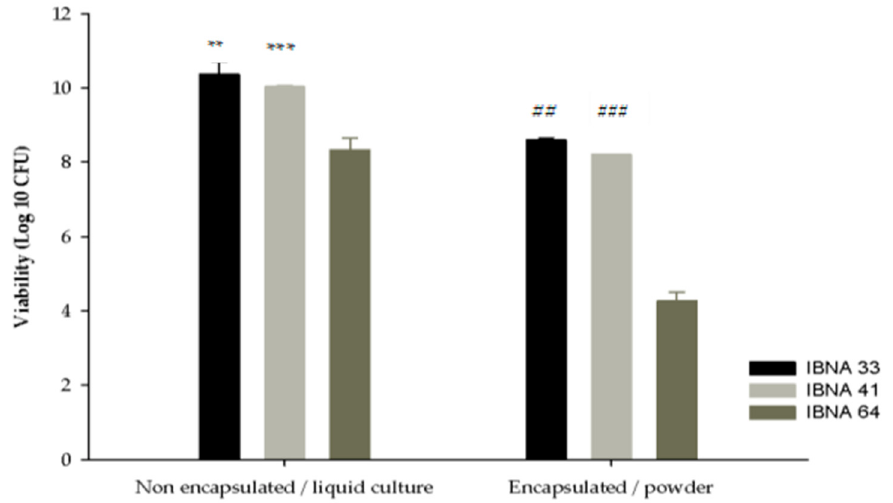
Figure 1. The bacterial population of L. salivarius (IBNA 33, IBNA 41) and L. acidophilus (IBNA 64) before and after spray drying process. Data are represented as means ± standard error of means (SEM) of three independent experiments. ** p < 0.0001 and *** p = 0.0003 compared with IBNA 64; ## p = 0.0159 compared with IBNA 41 and ### p < 0.0001 compared with IBNA 64.